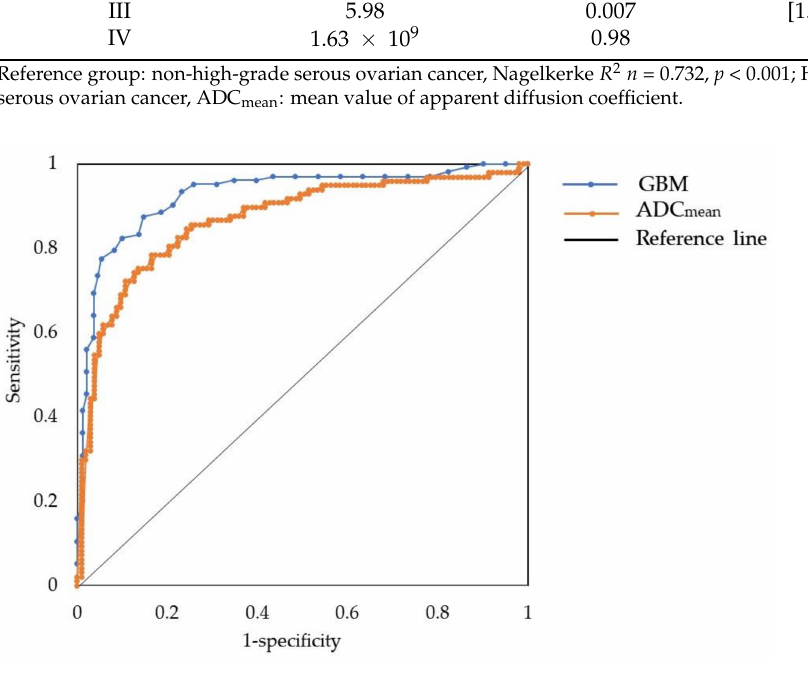
Figure 4. Comparison ROC curve between GBM and logistic regression for ADC mean . GBM: Gra- dient boosting model, ROC: receiver operating characteristic, ADC mean : mean value of apparent diffusion